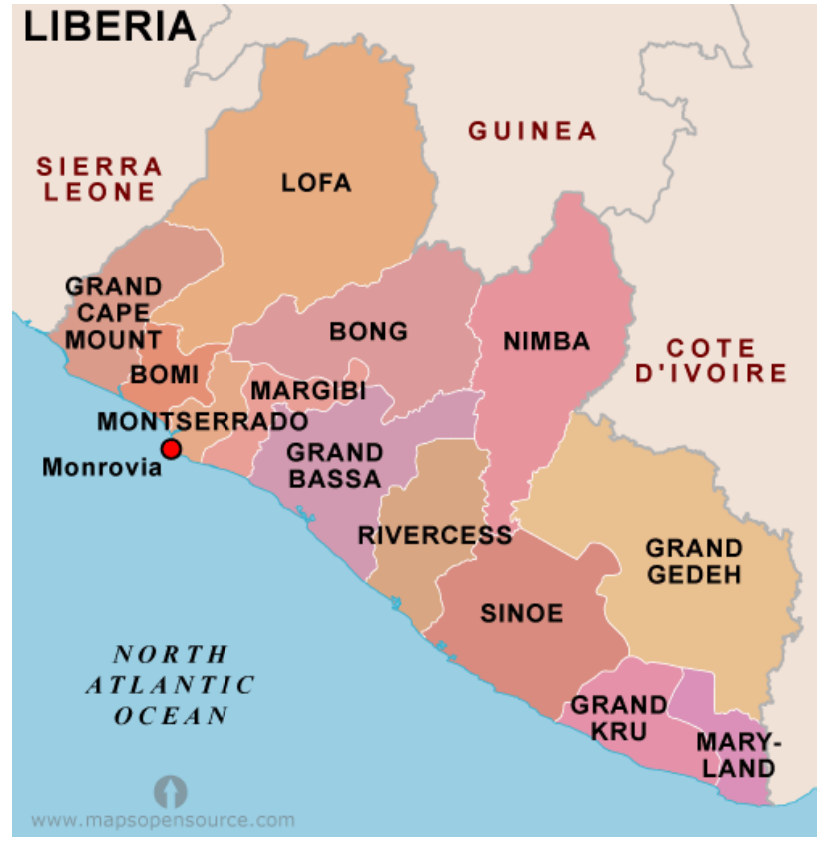
Figure 2. Counties of Liberia. Source: Retreived from http://www.mapsopensource.com/liberia- counties-map.html (accessed on 10 March 2021).